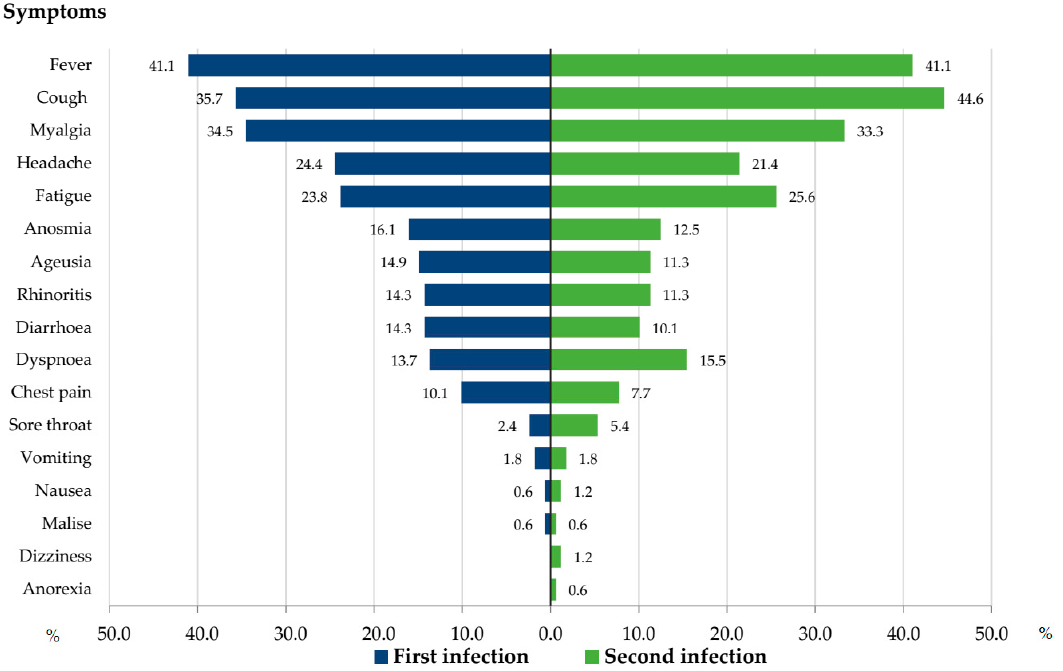
Figure 2. Percentage of patients with clinical symptoms at first and second